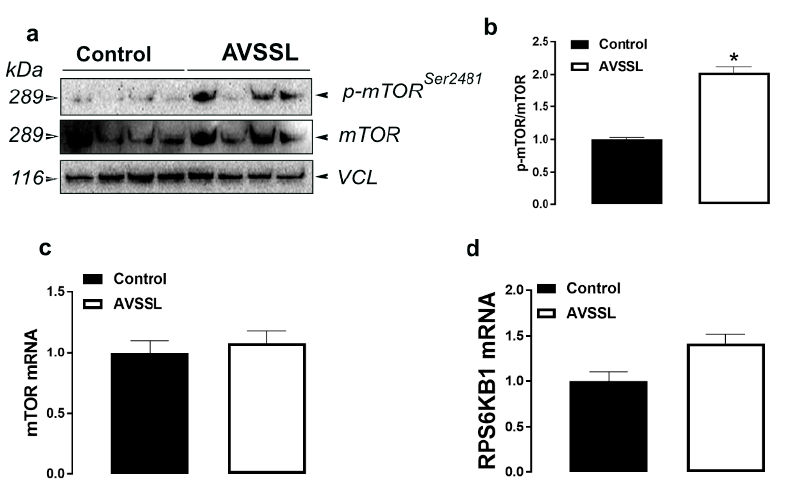
Figure 5. Effect of the phytogenic water additive AVSSL on the expression of protein metabolism- associated proteins and genes in breast muscle tissue. Protein levels of phosphorylated mTOR, mTOR, and VCL ( a , b ) were measured by Western blot and mRNA abundances of mTOR and RPS6KB1 ( c , d ) were determined by qPCR using the 2 − ∆∆ Ct method [21]. Data are presented as the mean ± SEM ( n = 8 birds/ group). * Denotes significant difference compared to the control group at p < 0.05. mTOR, mechanistic target of rapamycin; RPS6KB1, ribosomal protein S6 kinase beta-1.